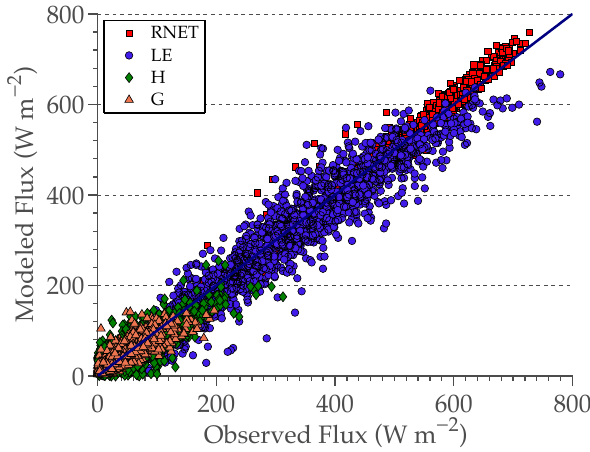
784 Fig. 6. Comparison of hourly TSEB_LUE estimates of latent heat flux over maize and soybean 785 Figure 6. Comparison of hourly TSEB-LUE estimates of latent field, generated using a fixed values 𝛽 ! and using 𝛽 ! as a function of Chl. The green circles are 786 heat flux over maize and soybean field, generated using a fixed val- ues β n and using β n as a function of Chl. The green circles are the latent heat fluxes from the canopy and red circles represent latent heat fluxes from the soil. 787 the latent heat fluxes from the canopy and red circles represent la- The blue filled circles are the total (soil+canopy) latent heat fluxes. 788 tent heat fluxes from the soil. The blue filled circles are the total (soil + canopy) latent heat fluxes.